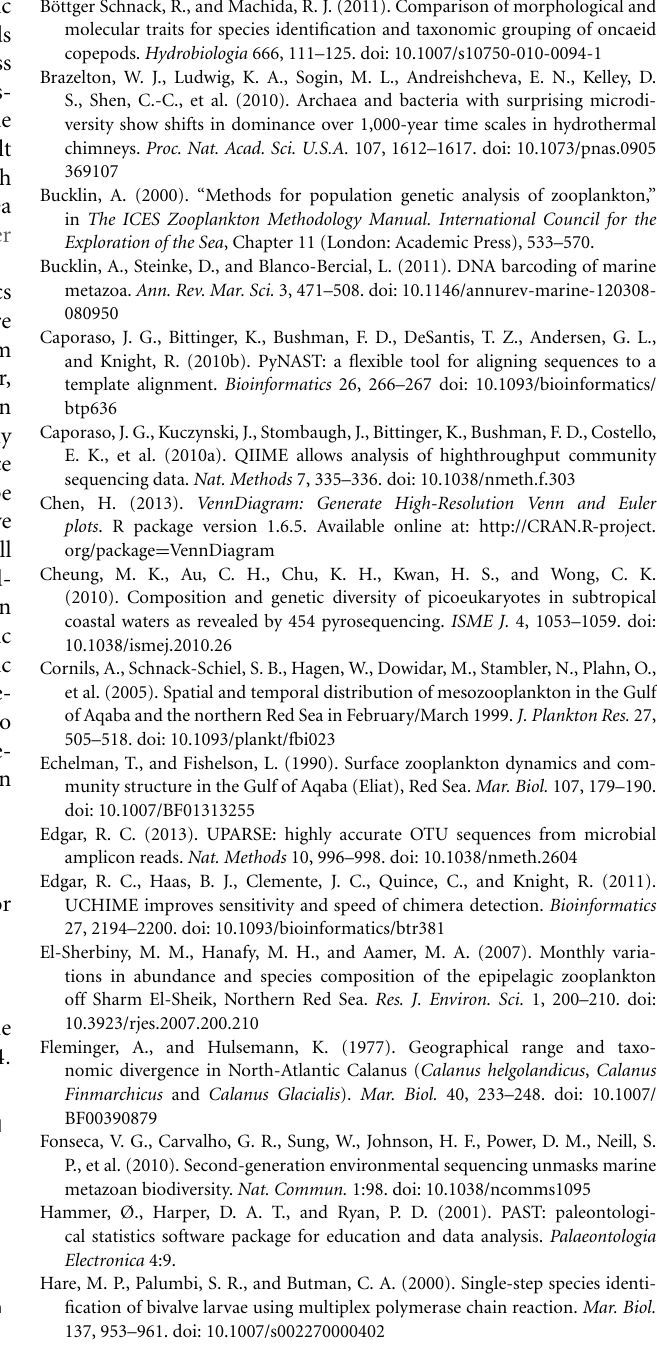
Figure S1 | Comparison of OTU richness per order for AmpliconNoise and UPARSE denoised datasets. Figure S2 | Comparison of OTU richness for between AmpliconNoise and UPARSE denoising techniques. Table S1 | Ancillary sampling data for each station. Table S2 | The number proportion of reads attributed to each taxa in each of the three reef